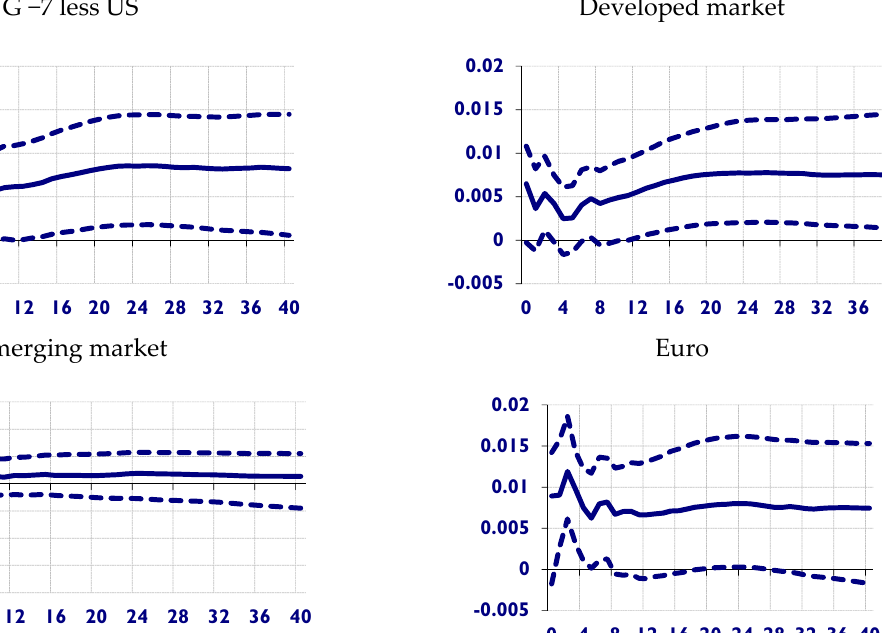
Figure 2. Group Impulse Response Functions of Real Equity Prices to a One Standard Deviation Positive Global Technology Shock (GTS − 164).